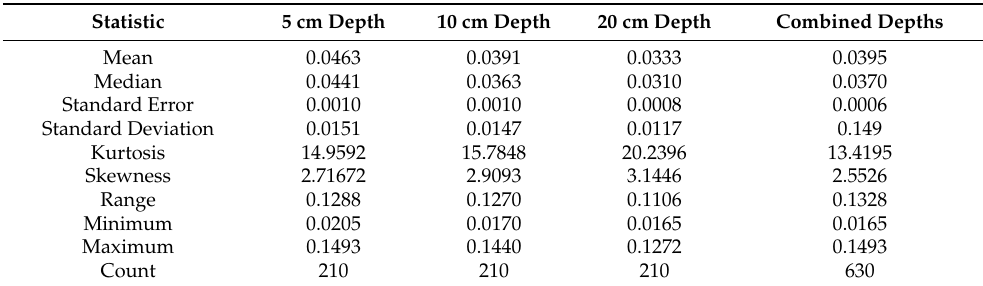
Table 4. Summary of descriptive statistics for standard erros at the 5, 10, and 20 cm d.